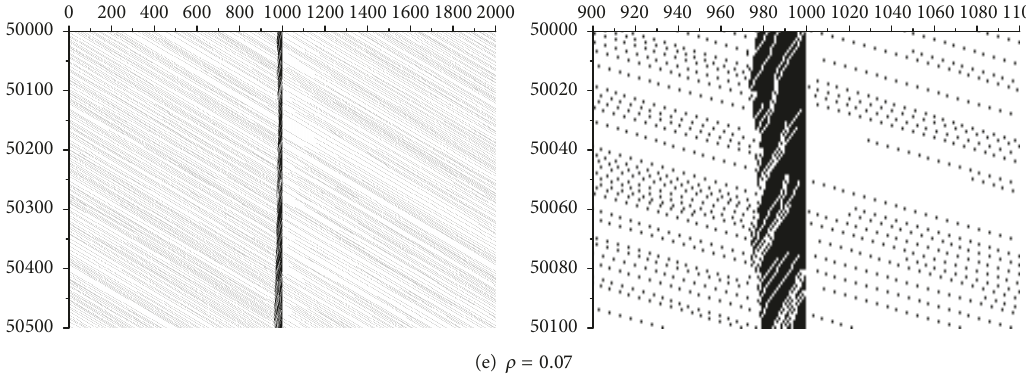
Figure 6: Spatiotemporal diagrams of the right lane in